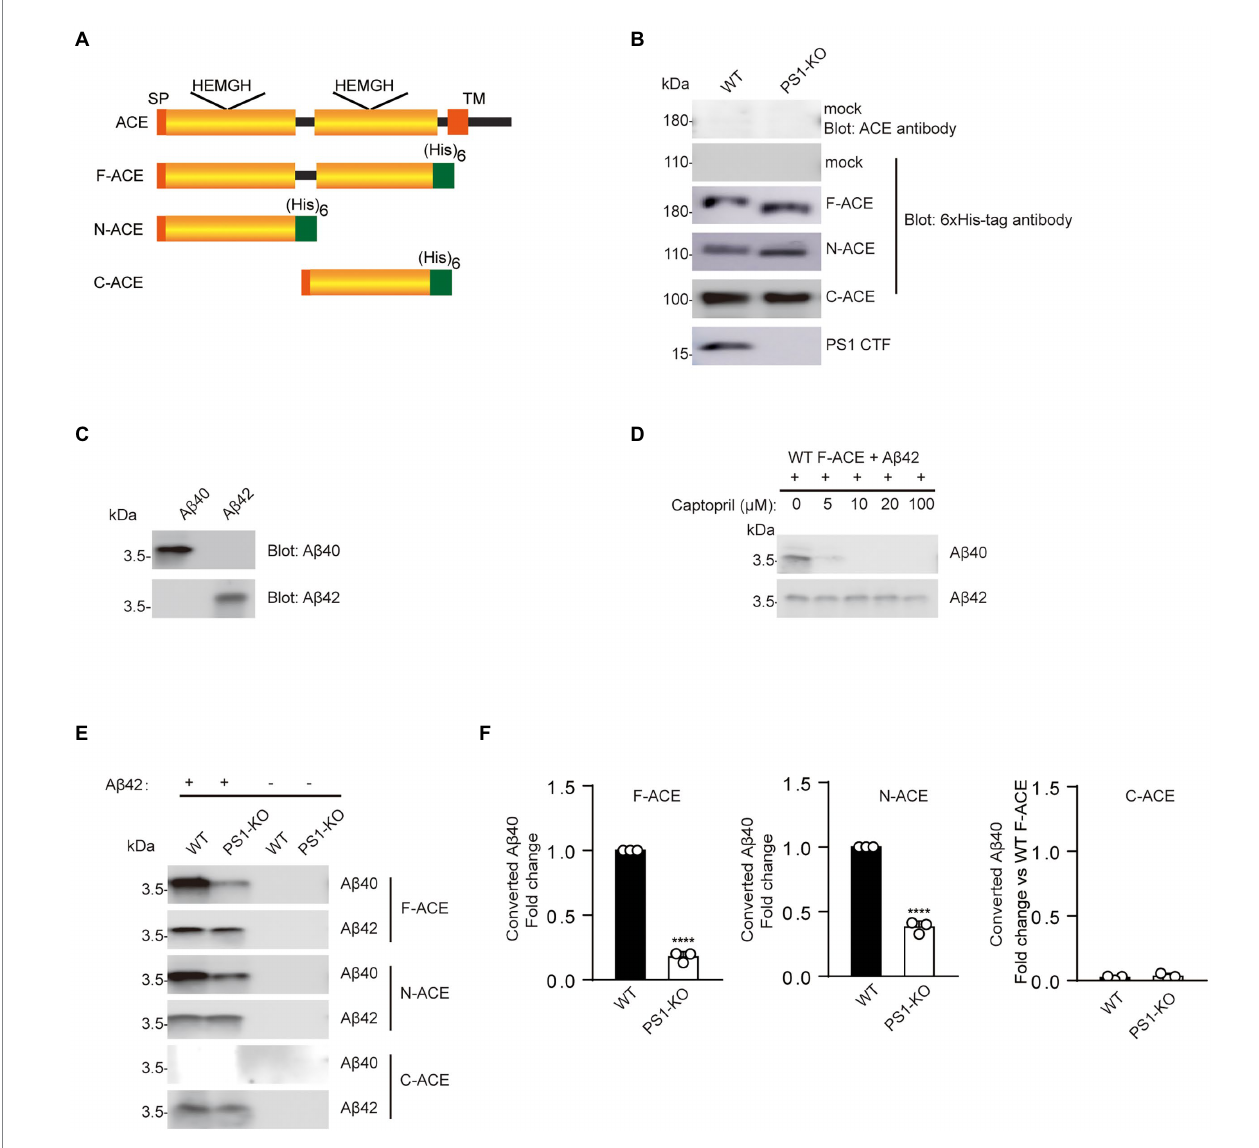
FIGURE 1 Recombinant F-ACE and N-ACE from PS1-KO fibroblasts exhibit decreased A β 42-to-A β 40-converting activity. (A) Schematic representation of human ACE and recombinant ACE proteins. The wild-type (WT) ACE protein consists of a signal peptide (SP), a single transmembrane domain (TM), and two homologous catalytic domains (yellow boxes). Recombinant ACE proteins (F-ACE, N-ACE and C-ACE) contain 6 histidine residues (green box) at the C-terminus and a SP at the N-terminus. (B) Western blots of 20 μ g protein from the lysate of WT and PS1-KO fibroblasts transfected with empty vectors (mock) were probed with anti-ACE and anti–6 × His-tag antibodies (Upper two panels). Western blots of 20 μ g of purified F-, N-, and C-ACE proteins from WT or PS1-KO fibroblasts were probed with anti–6 × His-tag or PS1-CTF antibodies (Lower four panels). (C) The specificity of the anti-A β 40 and anti-A β 42 antibodies was confirmed by Western blotting of 0.1 μ g of synthetic A β 40 and A β 42. (D) Captopril 0, 5, 10, 20, 100 μ M was incubated with purified F-ACE protein and synthetic A β 42 for 2 h. (E) Purified F-, N-, and C-ACE proteins were mixed with synthetic A β 42 and incubated at 37 ° C for 2 h. Western blots of the mixture were probed with anti-A β 40 and anti-A β 42 antibodies. The symbols (+) and ( − ) indicate with and without synthetic A β 42. (F) Quantification of A β 40 converted from A β 42. F-and N-ACE purified from PS1-KO cells showed lower A β -converting activity (A β 42-to-A β 40–converting activity) compared with proteins from WT fibroblasts. C-ACE did not show any A β -converting activity. Values represent the mean ± SEM; n = 3; ****, p < 0.0001, by unpaired two- tailed Student’s t test. F-ACE, full-domain ACE; N-ACE, N-terminal domain ACE; C-ACE, C-terminal domain